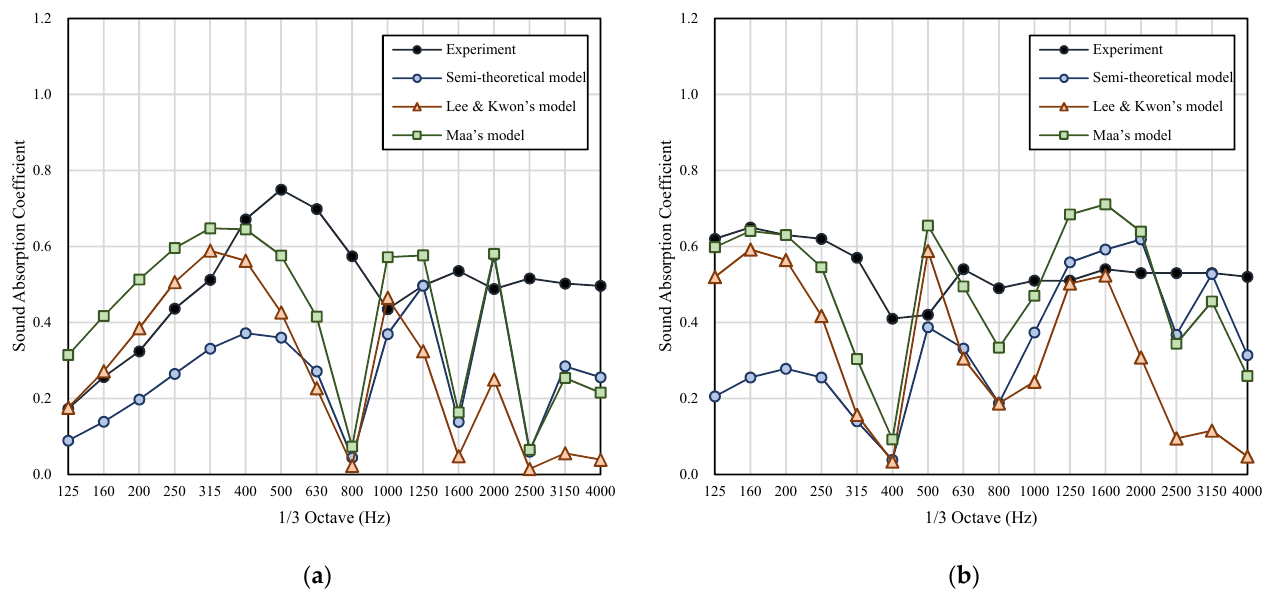
Figure 8. Results of conventional models with small side equivalent perimeter condition: ( a ) case E1; ( b ) case E2.